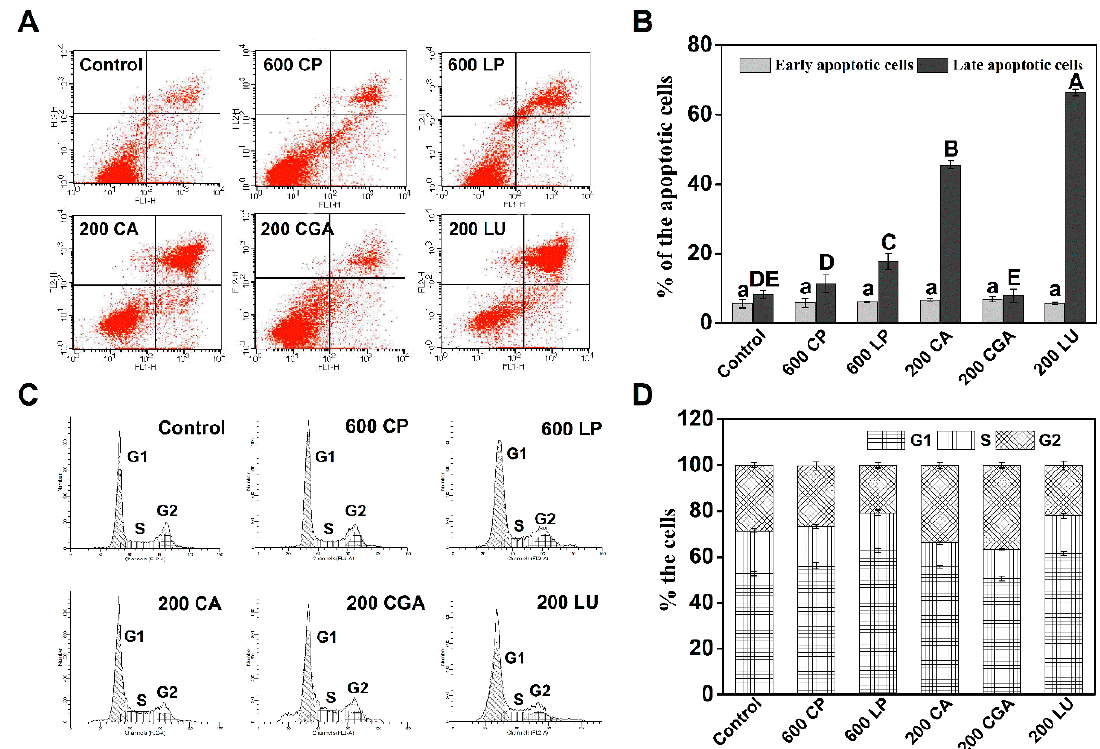
Figure 5. Effects of lettuce extracts and pure individual phenolic compounds on apoptosis and cell cycle in Caco-2 cells. (A) Representative images of flow cytometry apoptosis after 24 h treatments. (B) The percentage of early and late apoptotic cells. (C) Representative images of flow cytometry cell cycle after 24 h treatments. (D) Percentages in each cell cycle phase (G1, S, and G2). Different letters indicate significant difference at P < 0.05.